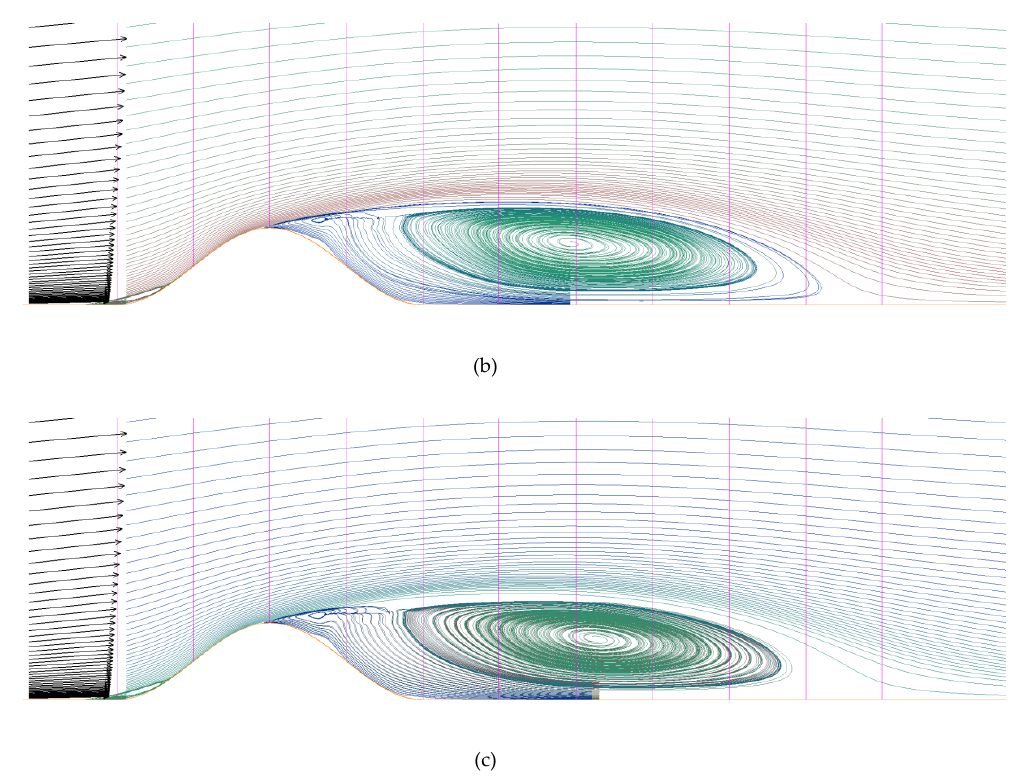
Figure 9. Streamlines for flow field with temporal and spanwise spatial averaging: ( a ) L = 9 h, ( b ) L = 27 h, and ( c ) L = 54 h.